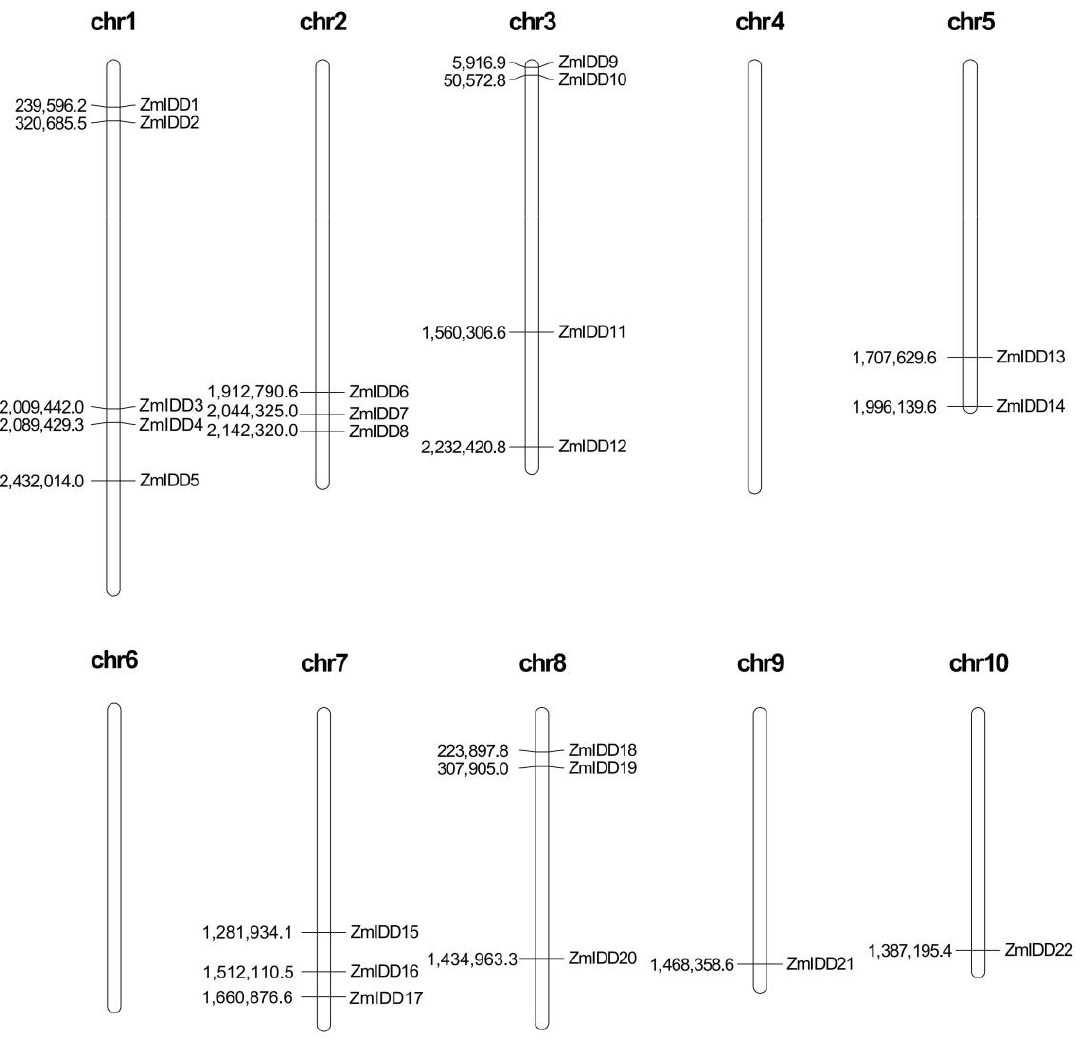
Figure 5. Distribution of ZmIDD genes in maize chromosomes. The chromosome numbers are indicated at the top of each chromosome image.